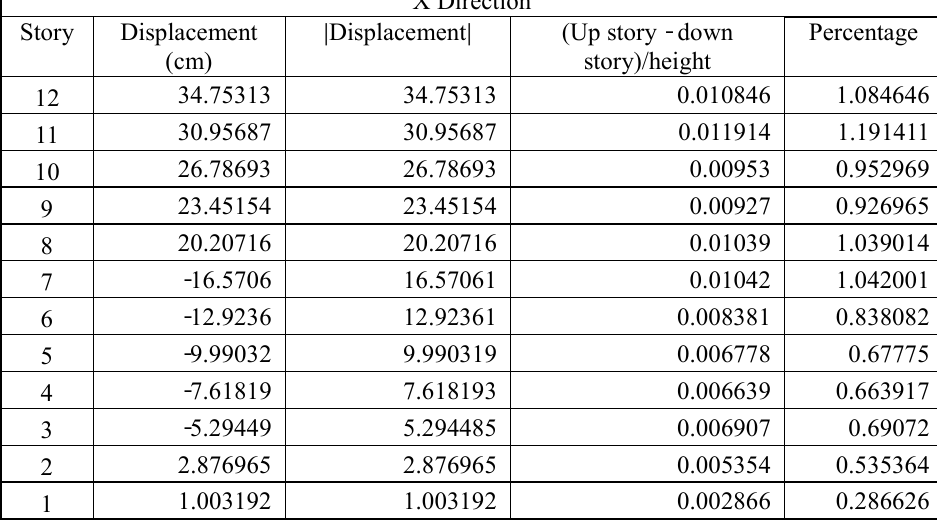
The results of 12-story structure under Northridge earthquake record in U1